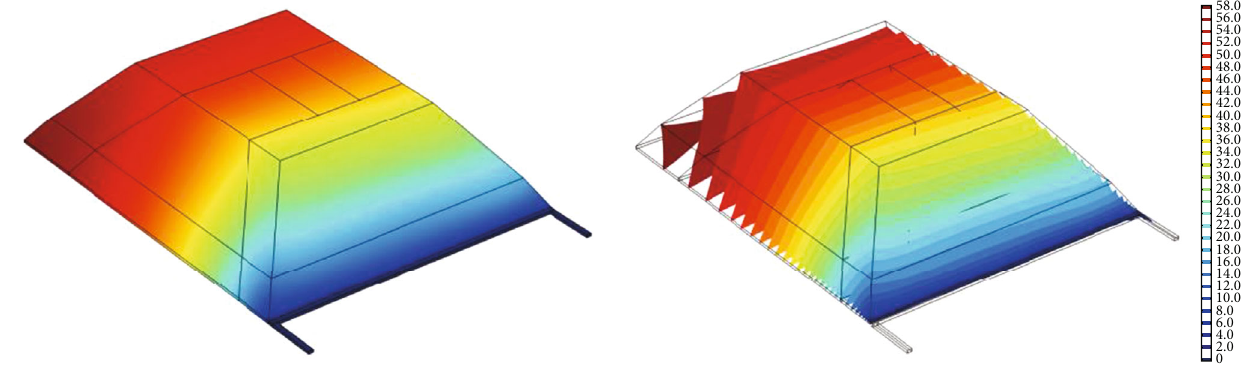
Figure 8: Three-dimensional distribution of gas concentration in goaf.